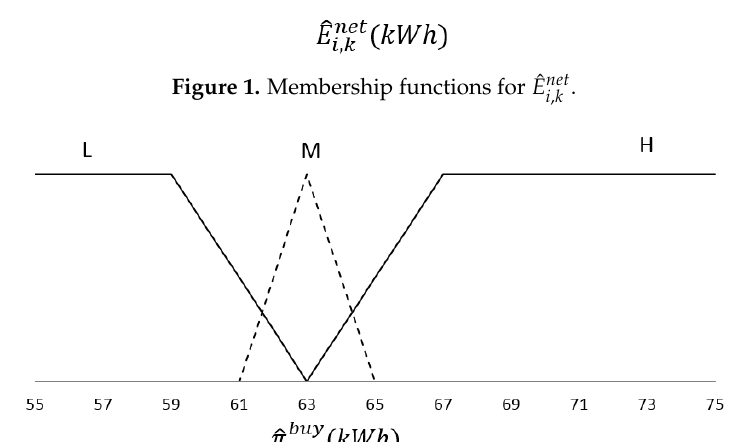
Figure 1. Membership functions for ˆ E net